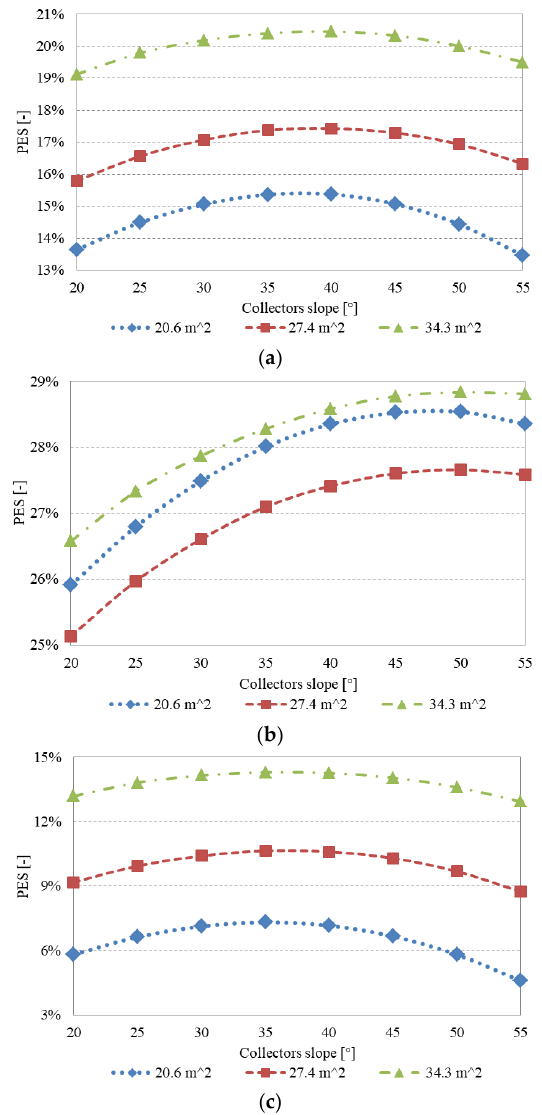
Figure 3. Primary energy savings as a function of the tilt angle and the solar field aperture area for: